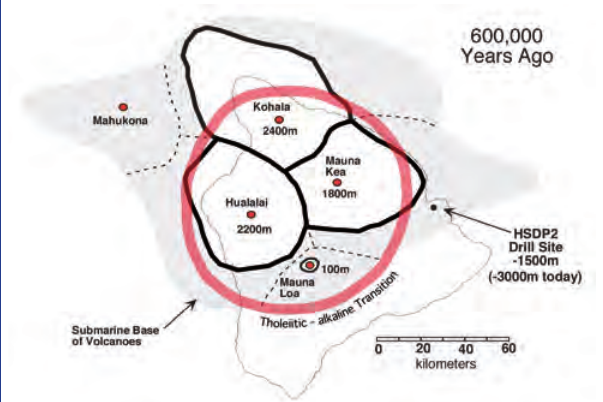
Figure 7. Map depicting the inferred geography of the island of Hawaii at a time corresponding to about 600 ka years ago represented by section at 3000 mbsl in the core. This map is based on modern topography and bathymetry for the older volcanoes, a long-term subsidence rate of 2.5 mm yr -1 for the shorelines, subaerial slopes for the volcanoes of 5.5°, and the volcano growth model of DePaolo and Stolper (1996). The red circle, based loosely on the geodynamic model of Ribe and Christensen (1999), delimits the location of the main magma-producing region in the plume, about 100–150 km below the Earth’s surface. Inside this circle melt fractions are relatively large, and the magma compositions produced are tholeiitic; outside, the magma production is minimal, and the magma compositions are